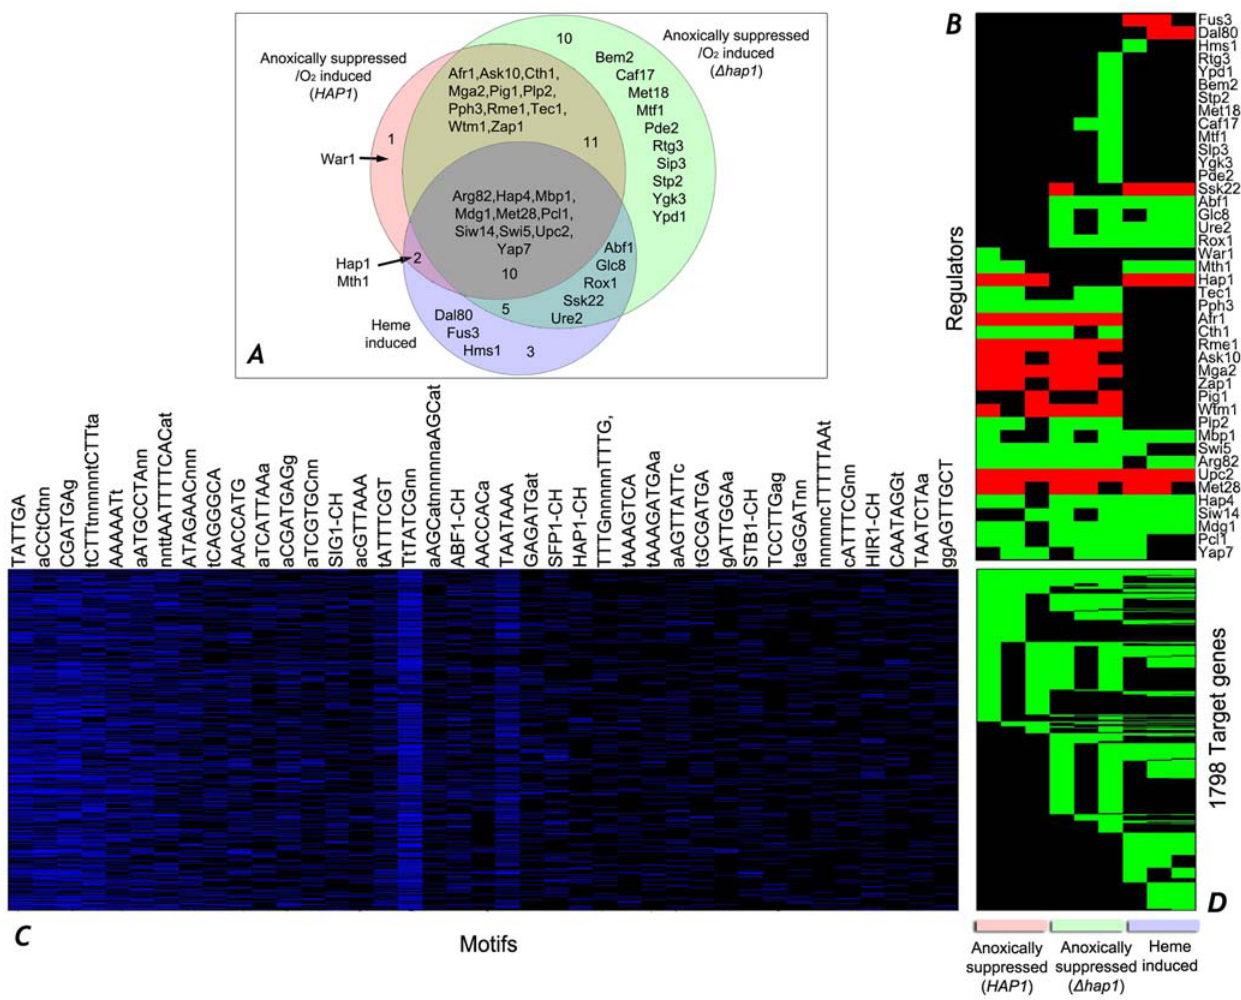
Figure 4. Heat maps showing predictive regulators, predictive motifs, and targets induced by oxygen and heme. (A) A Venn diagram illustrating the regulators involved in controlling hypoxically suppressed (oxygen-induced) genes in HAP1 and D hap1 cells, and heme-induced genes. For each experiment, the statistically significant regulators associated with the set of downregulated target genes are determined by use of a margin- based score (see Methods). (B) Patterns of up (red), down (green), and baseline (black) expression levels for the statistically significant regulators controlling downregulated target genes across the three experimental conditions. (C) The top-ranked sequence features learned by MEDUSA, as determined by a margin-based score, and their hits across the set of target gene promoters. The PSSMs learned by MEDUSA are represented by their consensus patterns. ChIP-chip occupancy features also occur in the list of most significant features. For example, SIG1-CH refers to ChIP-chip occupancy by the transcription factor SIG1 and appears as a highly-ranked promoter sequence feature. The presence or absence of a sequence feature in a gene’s promoter is represented by blue or black blocks respectively. (D) Discretized gene expression levels for the full set of target genes represented in the Venn diagram (total of 1798 genes), given by combining the down-regulated target gene list from each of the three experimental conditions. Note that the expression patterns include only down and baseline expression levels across all three conditions.